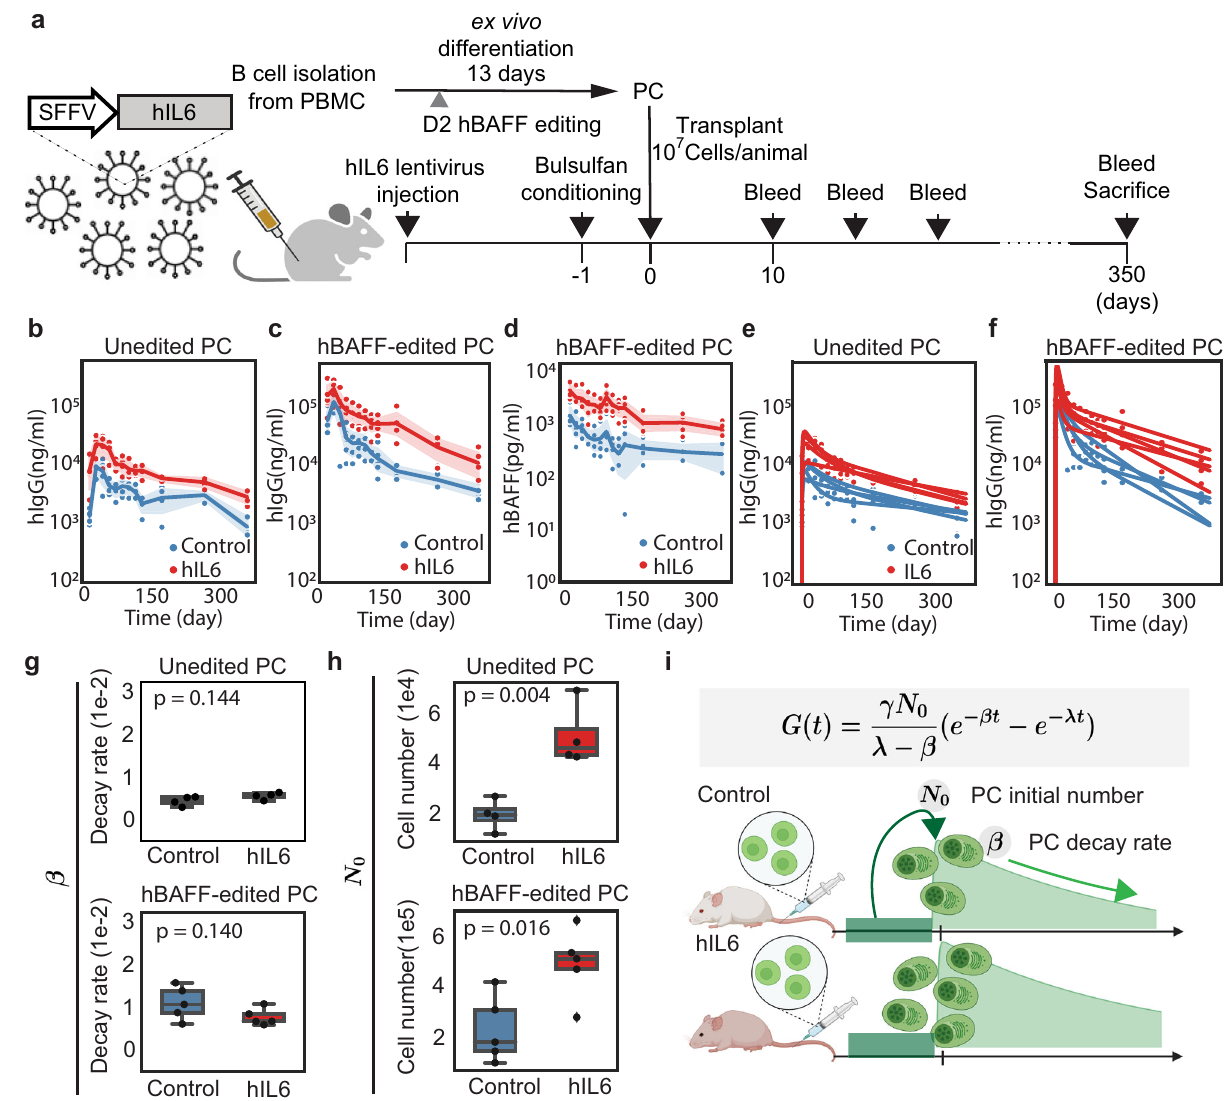
explain the observed hIgG dynamics in the indicated mouse models. g , h For eachanimal(Mock, n =4animals;hBAFF, n =5animals),weusedthe fi ttedcurves to calculate the decay rate and engrafted PC numbers. The box plot represents a central line denoting the median value (50th percentile), while the box contains the 25th to 75th percentiles of the dataset with black whiskers marking the maximum (95th percentile) and minimum (5th percentile). P values were cal- culatedusinganunpairedtwo-tailedWelch ’ s t -test. i